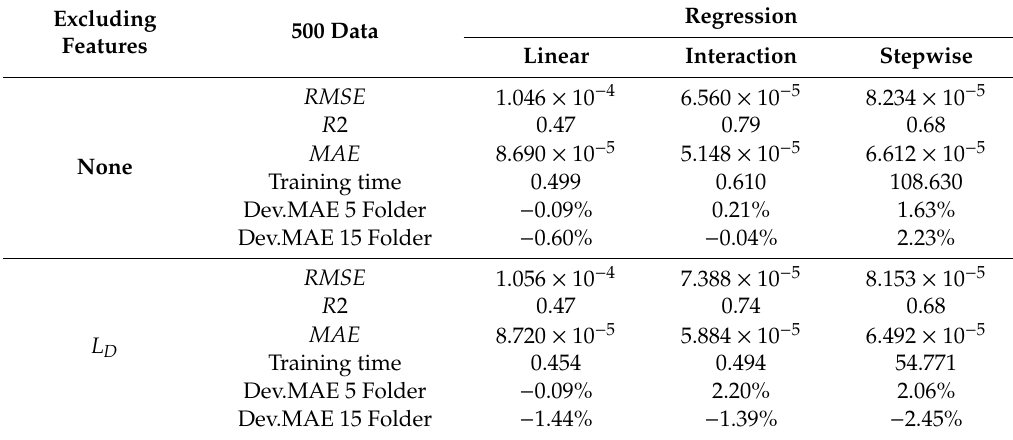
Table A1. Performance results for thickness predictor models using dataset of 500 sets of